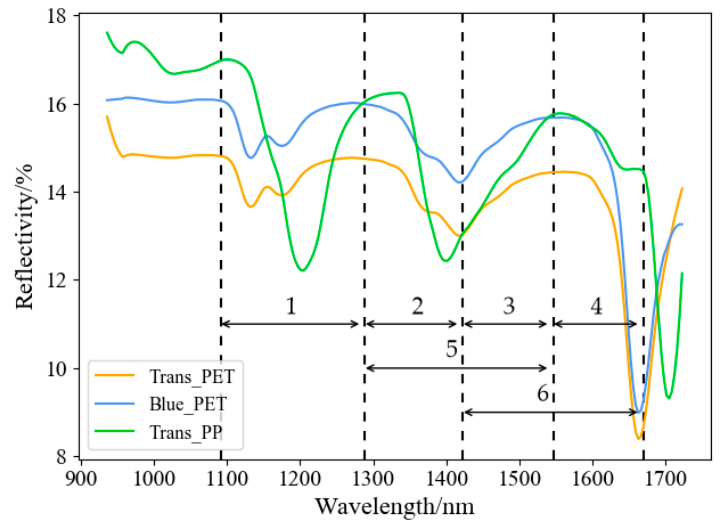
Figure 7. Spectral feature intervals. Interval 1: 1087.6 nm–1285.1 nm; Interval 2: 1285.1 nm–1419.2